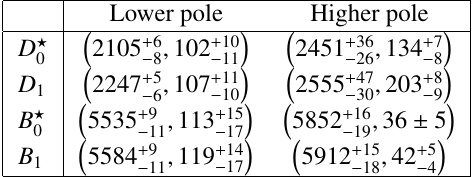
Figure 8. Typical near-threshold line shapes that emerge for compact (left panel) and molecular states (right panel). The dashed perpendicular lines indicate the location of the threshold. Note the cusp at the threshold for the molecular scenario. The x -axis shows M = m 1 + m 2 + E . Figure inspired from